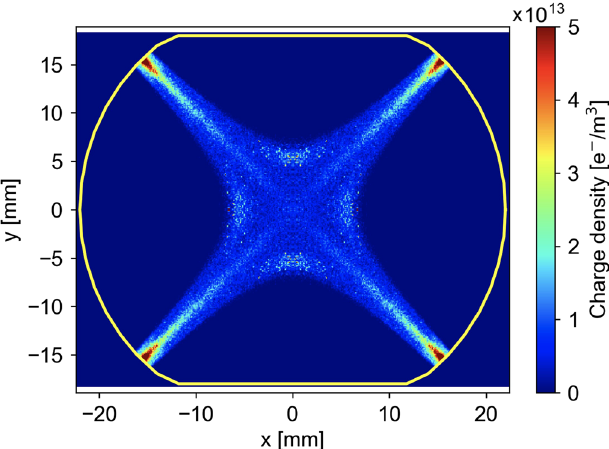
FIG. 1. Electron distribution in the LHC arc quadrupoles at injection energy as seen right before the arrival of a bunch (from a PIC